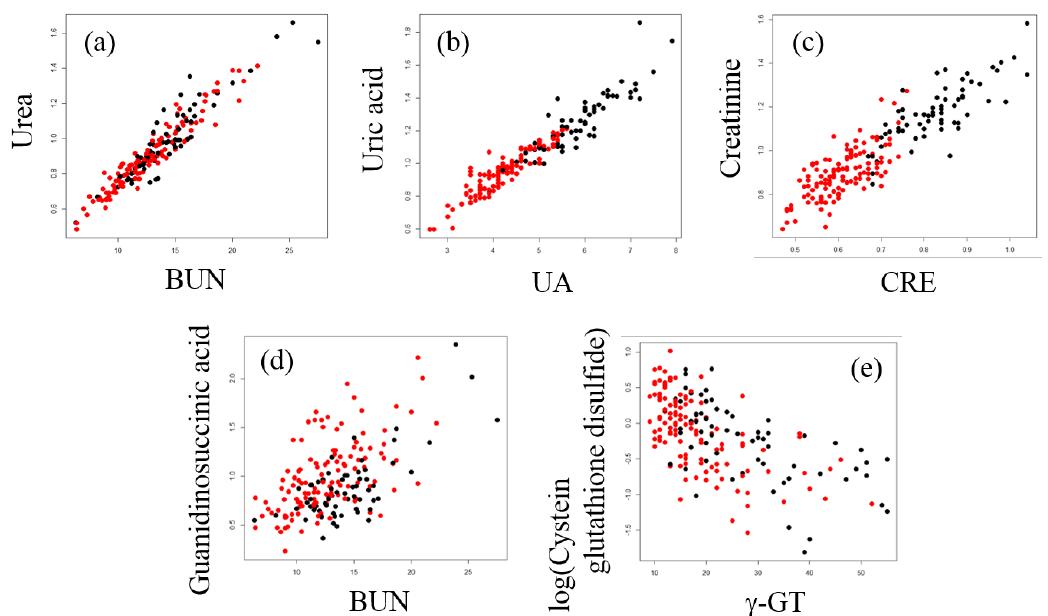
Figure 5. Scatter plot of five pairs of diagnostic blood tests and plasma metabolites. Black circles indicate samples from males and red circles indicate samples from females. ( a ) Blood urea nitrogen (BUN) test and urea, ( b ) uric acid (UA) test and uric acid, ( c ) creatinine (CRE) test and creatinine, ( d ) BUN test and guanidinosuccinic acid, and ( e ) gamma-glutamyl transpeptidase ( γ -GT) test and cysteine glutathione disulfide.